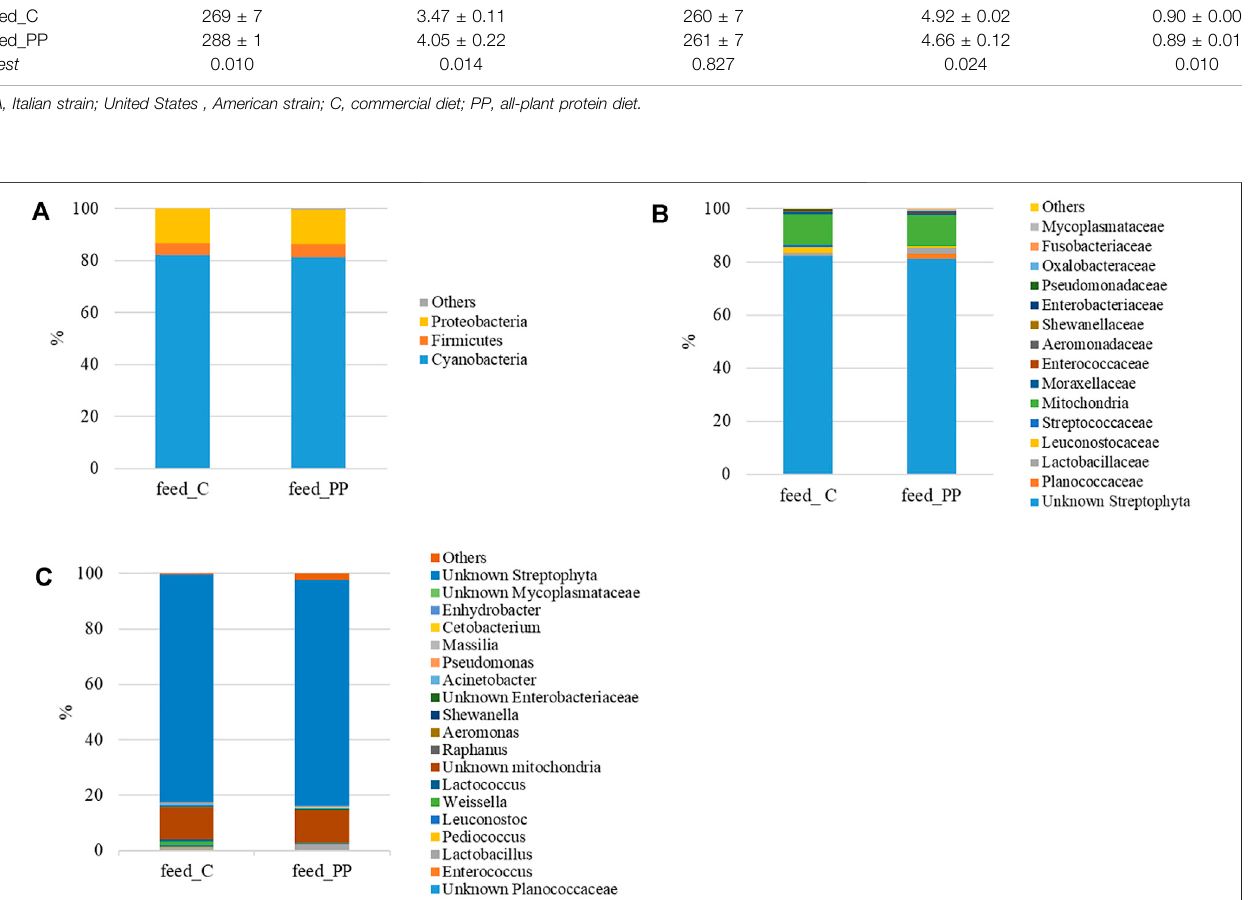
Frontiers in Physiology |